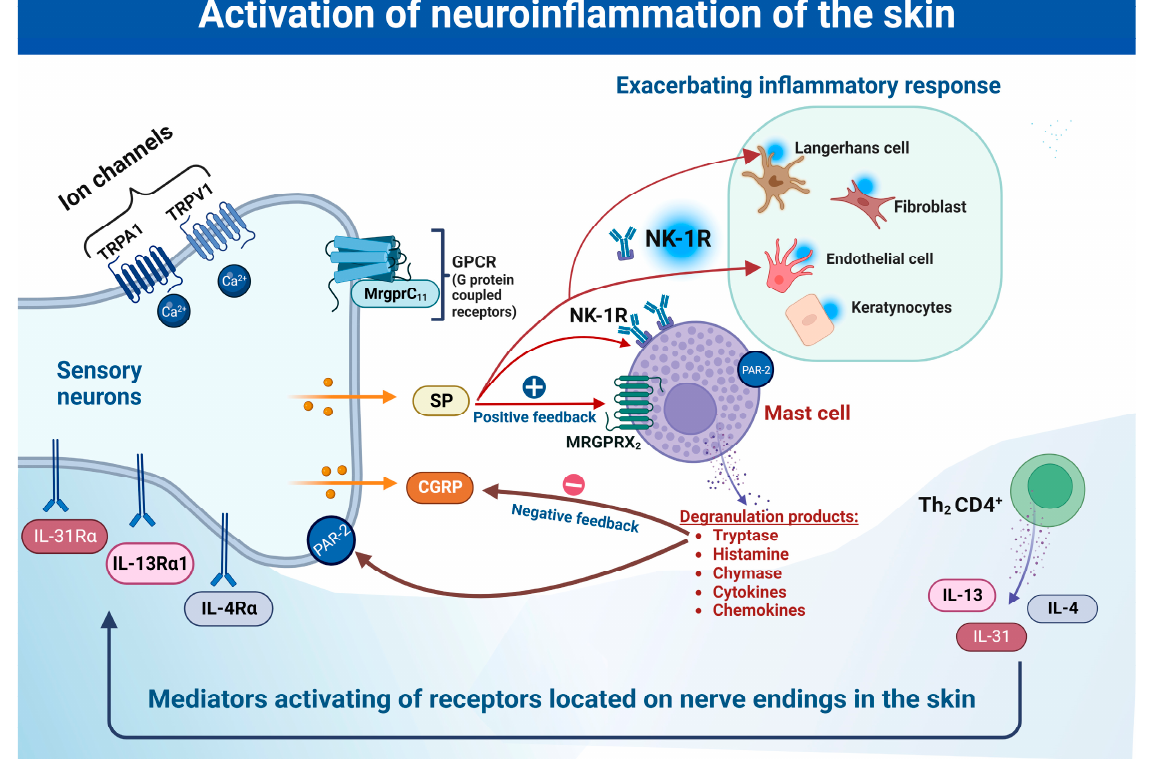
Figure 1. In the neurogenic inflammatory pathway, peripheral nerve endings communicate with various skin cells, such as keratinocytes, melanocytes, fibroblasts and MCs, and also with immune cells via neurotrophins and neuropeptides. In neurogenic inflammation, an important role is played by MCs, on the surface of which there are numerous receptors for neuropeptides secreted by nerve endings. After activation of the receptors, mast cells degranulate and release proteases, cytokines and histamine. Tryptase binds to the PAR-2 receptor, activating it and releasing neuropeptides such as CGRP and SP, which are responsible for itching and scratching. PAR-2 activation is associated with pain perception. Tryptase directly affects CGRP, causing its degradation and negative feedback. On the other hand, SP, acting on the NK-1R and MRGPRX2 receptors on mast cells, activates them, causes cell degranulation and intensifies the inflammatory response. This response also involves TH2CD4+ immune cells that release cytokines IL-4, IL-13 and IL-31; these cytokines, as mediators, activate receptors on nerve endings, which intensifies itching in skin diseases. Ca 2+ -dependent TRPV1 and TRPA1 ion channels can communicate with each other and, when activated, increase the release of neuropeptides, thereby exacerbating neurogenic skin inflammation.